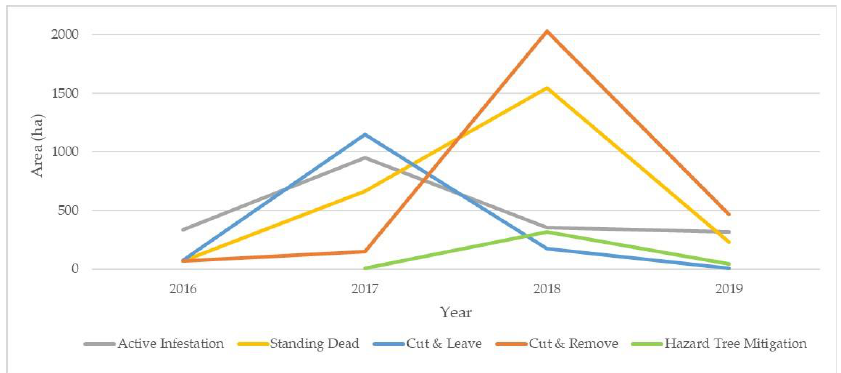
Figure 5. Acreage of active infestation and treatment type by year.